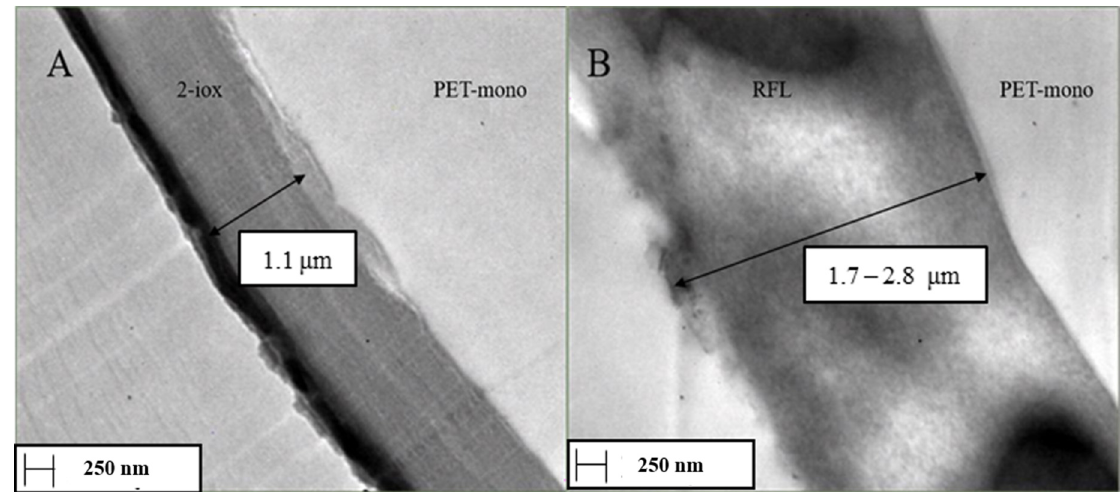
Figure 6. TEM images of activated 2-iox PPOL ( A ) and Epoxy + RFL adhesive ( B ). Thickness is 1.1. µ m for the PPOLs and between 1.7 and 2.8 µ m for the Epoxy +